Question: Write a single sentence explaining what this figure depicts.
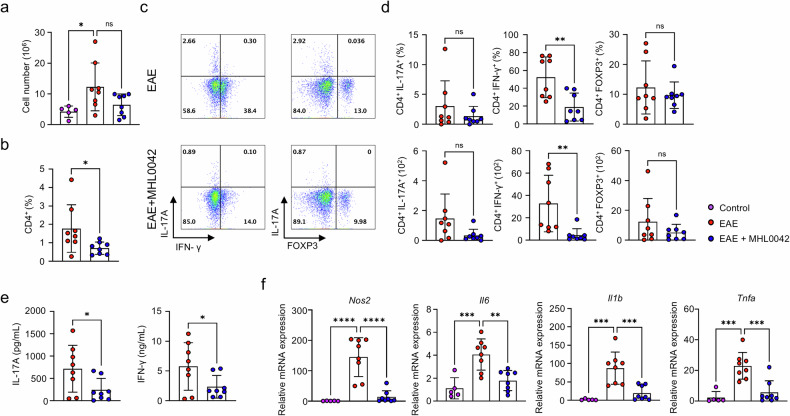
Answer: Treatment with Veillonella ratti MHL0042 modulates the central nervous system immune environment. Spinal cord-infiltrating lymphocytes were isolated and re-stimulated with the MOG 35–55 peptide. a Total number of central nervous system-infiltrating cells isolated from control, experimental autoimmune encephalomyelitis (EAE), and V. ratti MHL0042-treated EAE mice. b The frequency of MOG-specific CD4⁺ T cells isolated from EAE mice and V. ratti MHL0042-treated EAE mice calculated as a percentage of total live cell population. Specific CD4 + cell lineages, CD4⁺IL-17A⁺, CD4⁺IFN-γ⁺, and CD4⁺FOXP3⁺ cells, were then analyzed using flow cytometry under live CD4⁺ gating. c Representative fluorescence-activated cell sorting plot analysis. d The frequencies and numbers of specific lineages of CD4 + cells, CD4⁺IL-17A⁺, CD4⁺IFN-γ⁺, and CD4⁺FOXP3⁺ cells, calculated as percentages of CD4⁺ T cells. e IL-17A and IFN-γ concentrations in culture supernatants. Culture supernatants from MOG 35–55 -re-stimulated spinal cord-infiltrating lymphocytes were collected for enzyme-linked immunosorbent assay-based quantification of secretory pro-inflammatory cytokines. f Assessment of central nervous system inflammatory responses was conducted using reverse transcription-PCR. Relative mRNA expression levels of Nos2 , Il6 , Il1b , and Tnfa in spinal tissues from control, EAE, and V. ratti MHL0042-treated EAE mice. Data are presented as mean ± standard deviation from control ( n = 5), EAE ( n = 8), and V. ratti MHL0042-treated EAE ( n = 8) groups, * P < 0.05; ** P < 0.01; *** P < 0.001; **** P < 0.0001. IFN, interferon; MOG, myelin oligodendrocyte glycoprotein; ns, not significant; TNF, tumor necrosis factor.